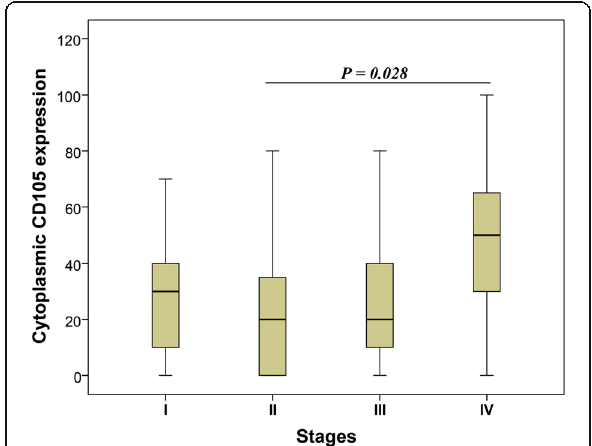
Fig. 3 Box plot of cytoplasmic CD105 expression levels for TNM stage in colorectal cancer. Based on the standard definitions, each box-plot shows the median (bold line) and interquartile lines (box). The results of Mann – Whitney U test showed that there was a statistically significant difference in terms of the mean expression levels of CD105 between stage II and IV in tumor cells ( P =